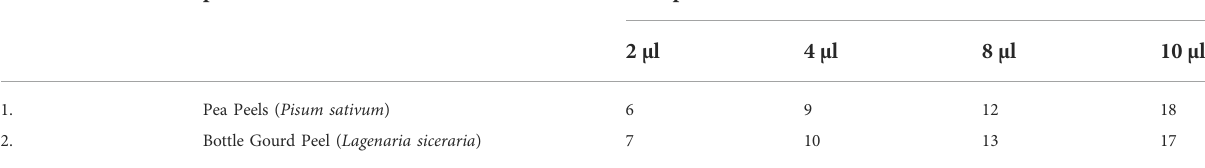
TABLE 1 Zone of inhibition of biosynthesized silver nanoparticles produced by Escherichia coli . S.